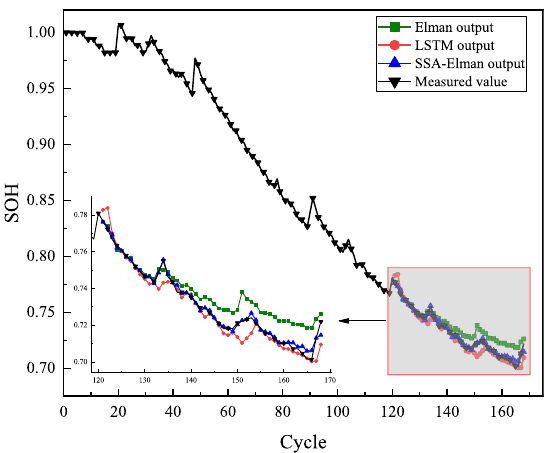
Fig. 12 The outputs of SSA-Elman, Elman and LSTM when using 70% training data